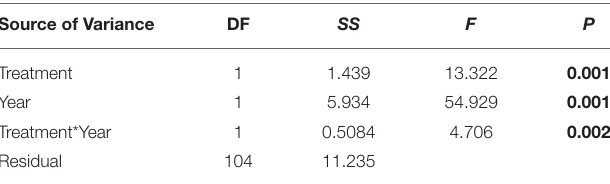
TABLE 1 | Summary of two-way PERMANOVAs ( F and P -values) on Bray-Curtis community composition from 2015 to 2018. Source of Variance